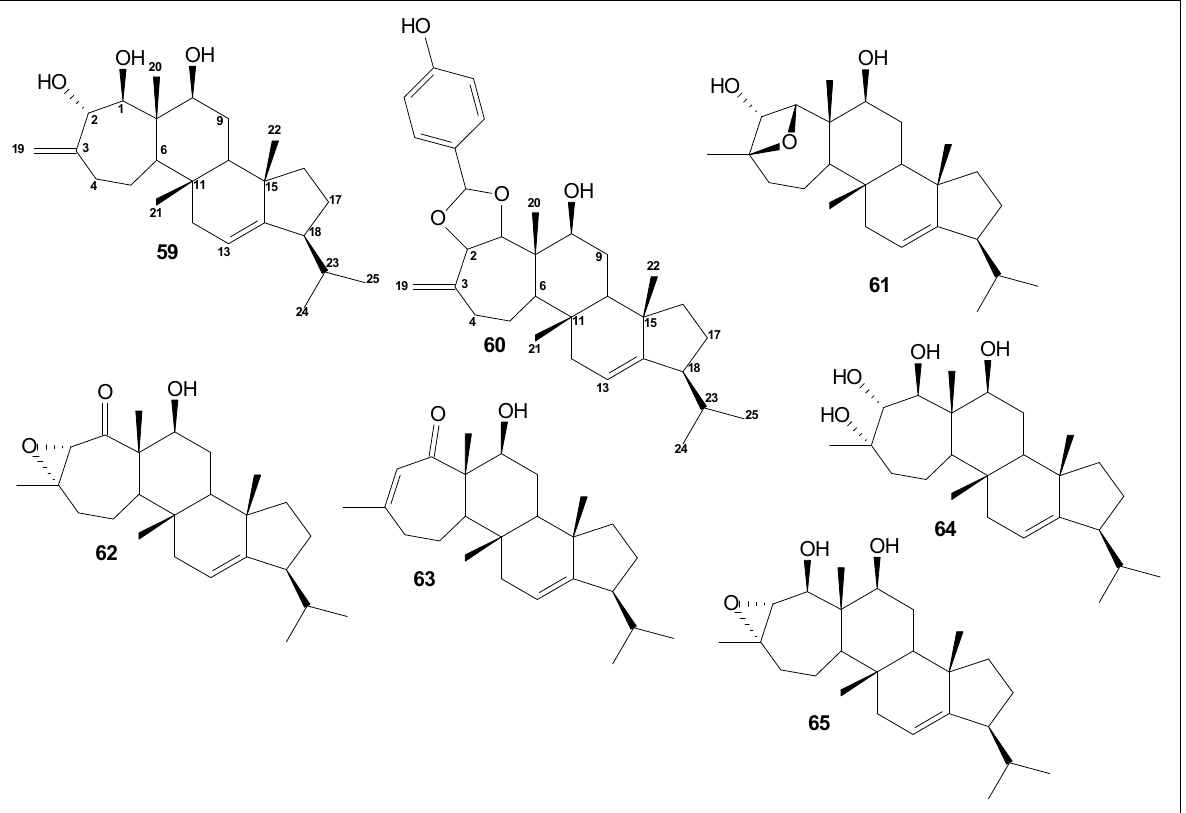
Figure 1. Depsidones ( 1–8 , 10–14 , 21–23 , 26–28 , 32 , 35 , 39 , 45–46 , 48–50, 69–70, 83–84, 86, 88 ), depsides ( 15 , 33 , 47 , 51–54 , 85, 87, 93 ), phthalides ( 9 , 34 , 59, 71–72 ), cyclopeptides ( 16–20 ), nitrogen-containing compounds ( 90–91 ), indanones ( 40–41 ), diarylethers ( 25 , 41–43 , 55–57, 67–68, 79–82 ), pyrones ( 24 ), benzoic acid derivative ( 31 ), orcinol/orsenillate derivatives ( 29–30 , 36–38 , 44, 66, 73–74, 89, 92 ), anthraquinones ( 75–77 ), chromone ( 78 ), sesterpenoids ( 59–65 ) and sterols ( 94–97 ) from A. unguis .